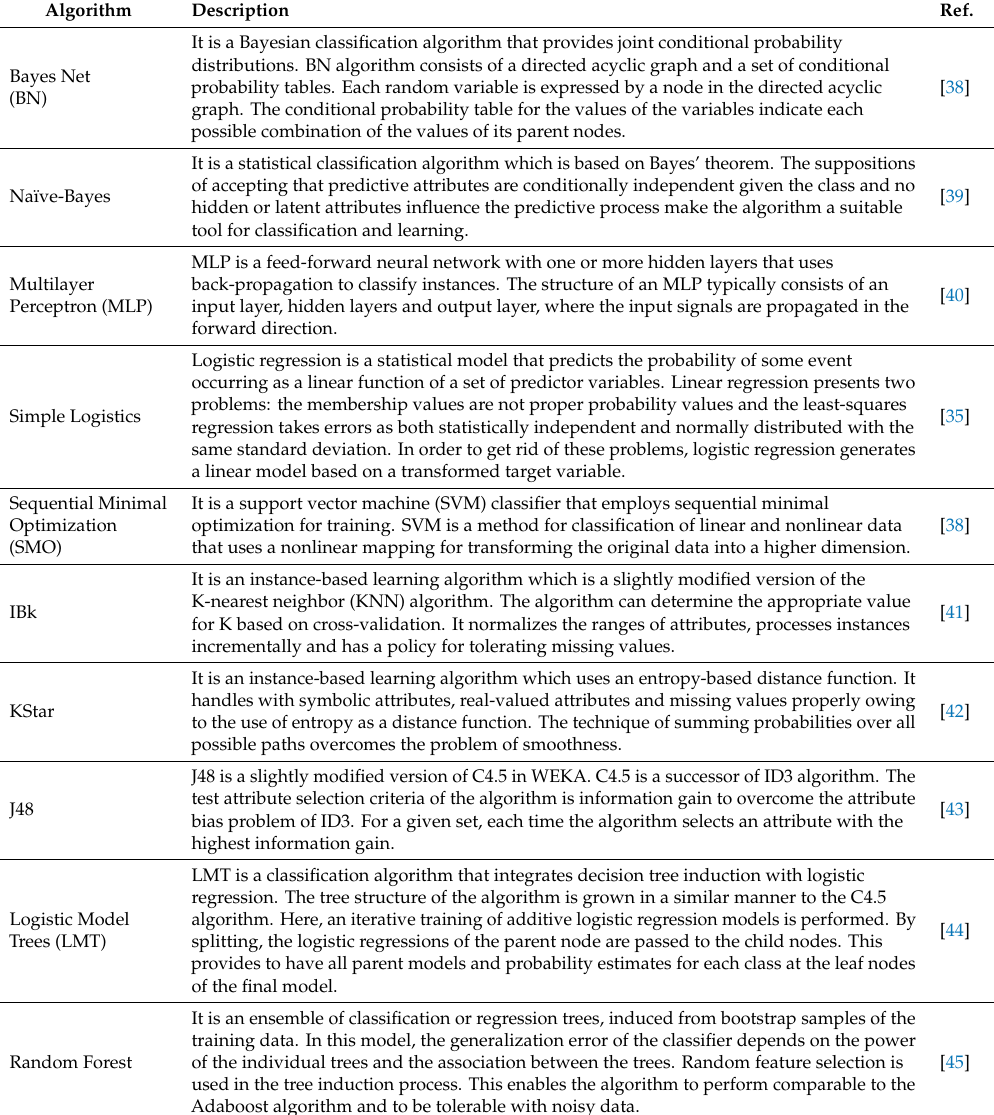
Table 4. Description of the data mining algorithms used in the present work (elaborated from